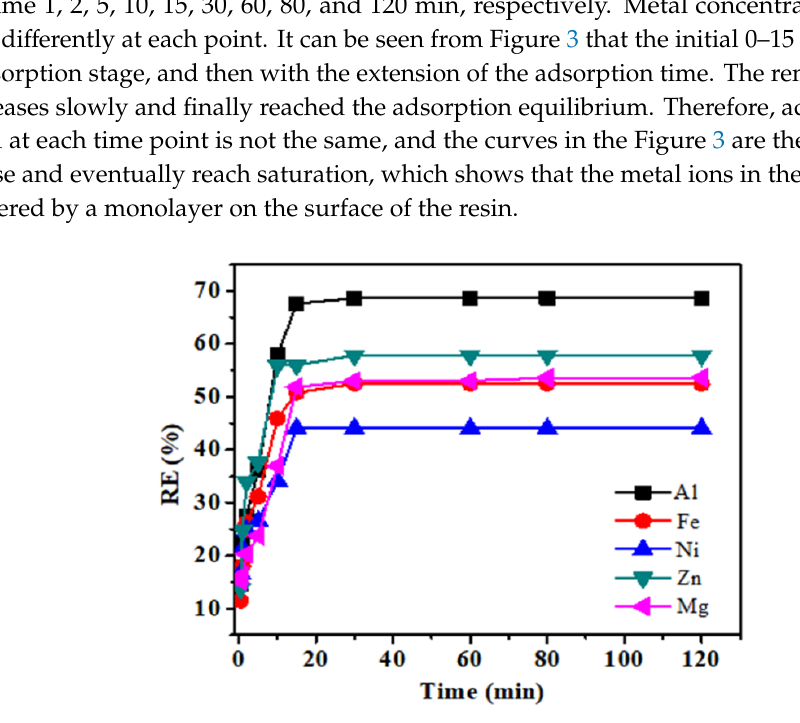
Figure 3. Effect of time on the uptake of metals Al(III), Fe(II), Zn(II), Mg(II) and Ni(II) using AmberliteIR-120 (temperature, 318 K; sorbent dose, 0.02 g; stirring speed, 150 rpm).